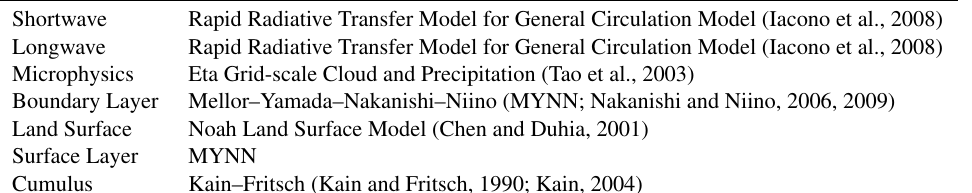
Table 1. Summary of WRF model configuration.